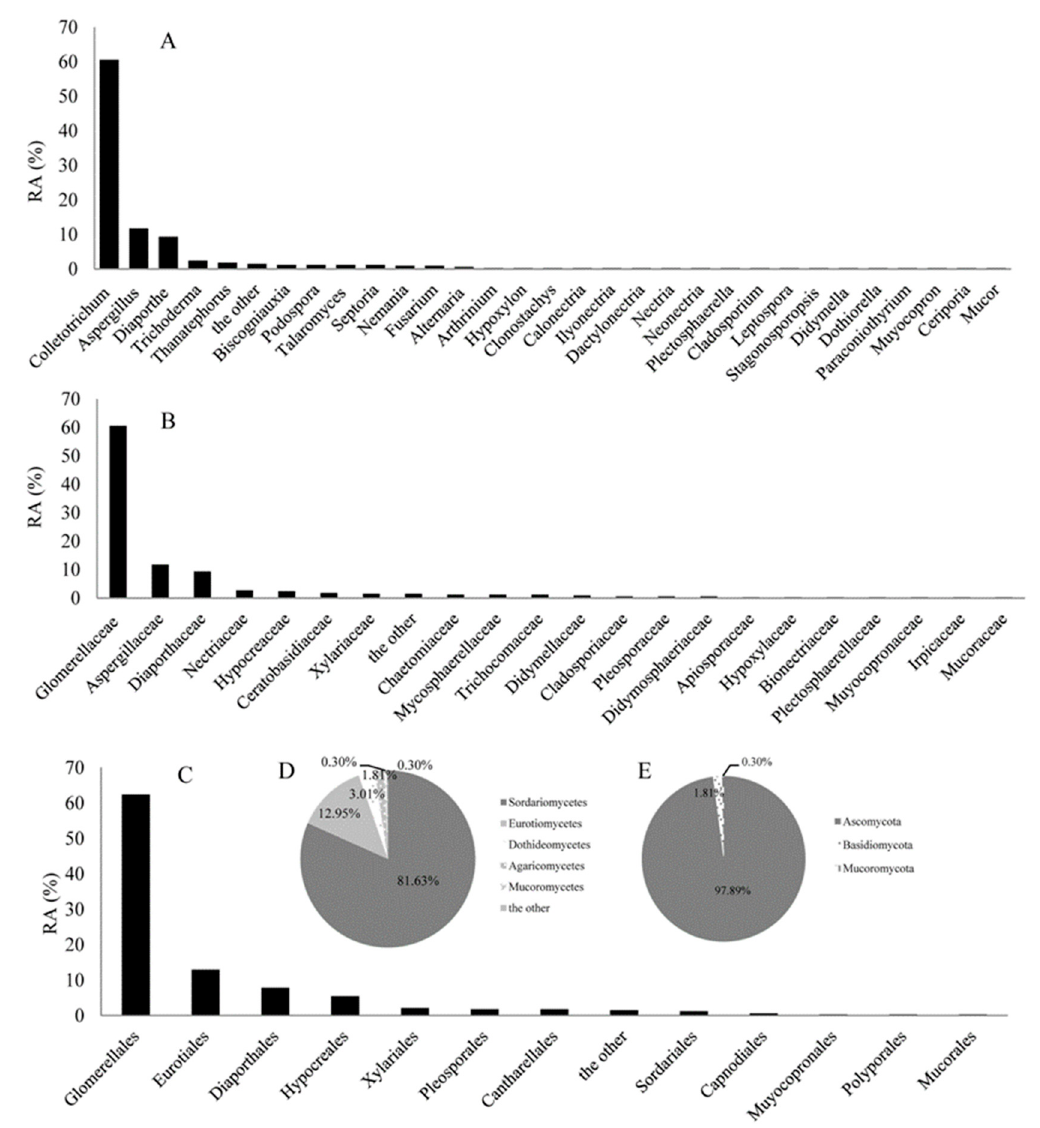
Figure 1. The relative abundance (RA, %) of endophytic fungi at the level of genus ( A ). Family ( B ), order ( C ), class ( D ), and phylum ( E ).